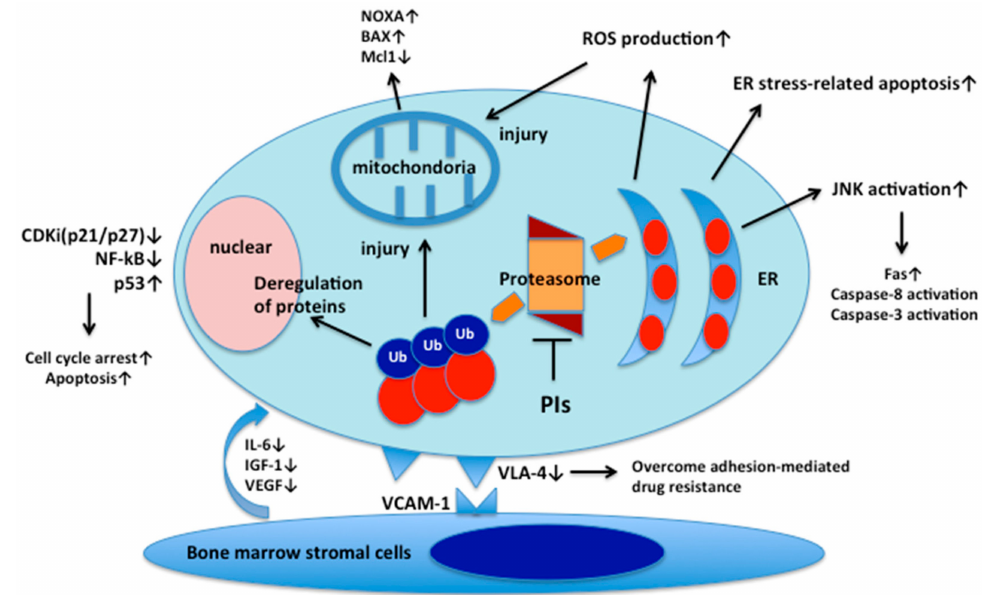
Figure 1. Molecular e ff ects of proteasome inhibition on multiple myeloma cells.